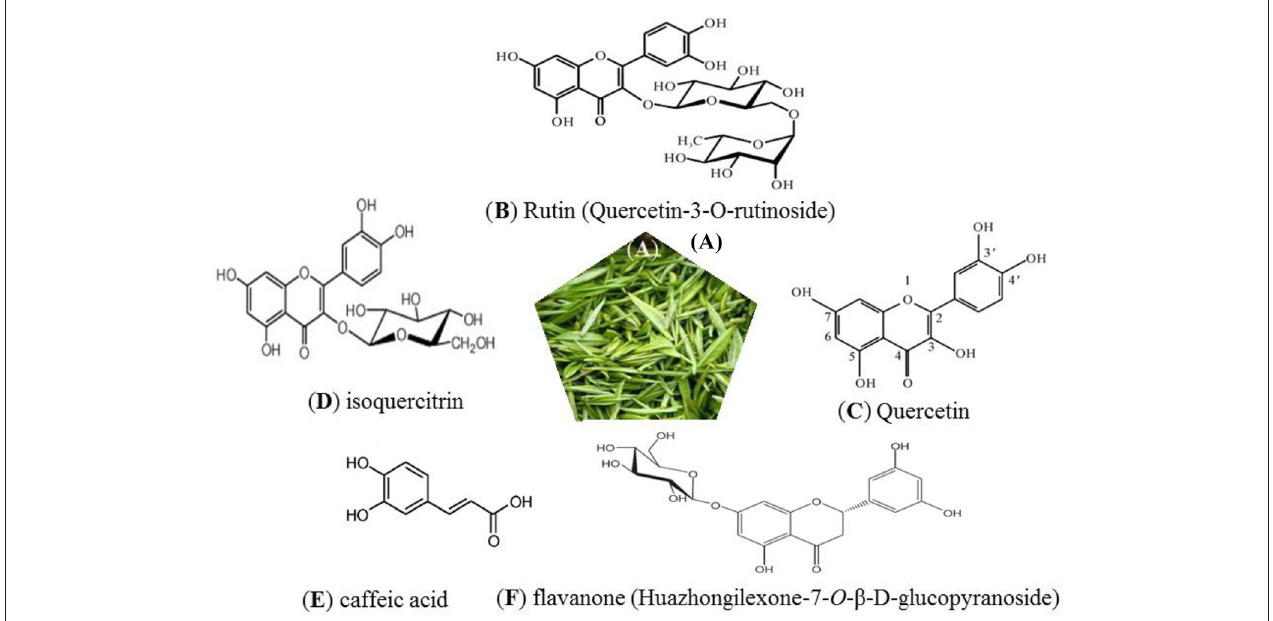
FIGURE 1 | Leaves of Ilex hainanensis Merr., known as “Shan-Lv-Cha” (A) . Structure of several known constituents: rutin (B) , quercetin (C) , isoquercitrin (D) , caffeic acid (E) , and flavanone (F)